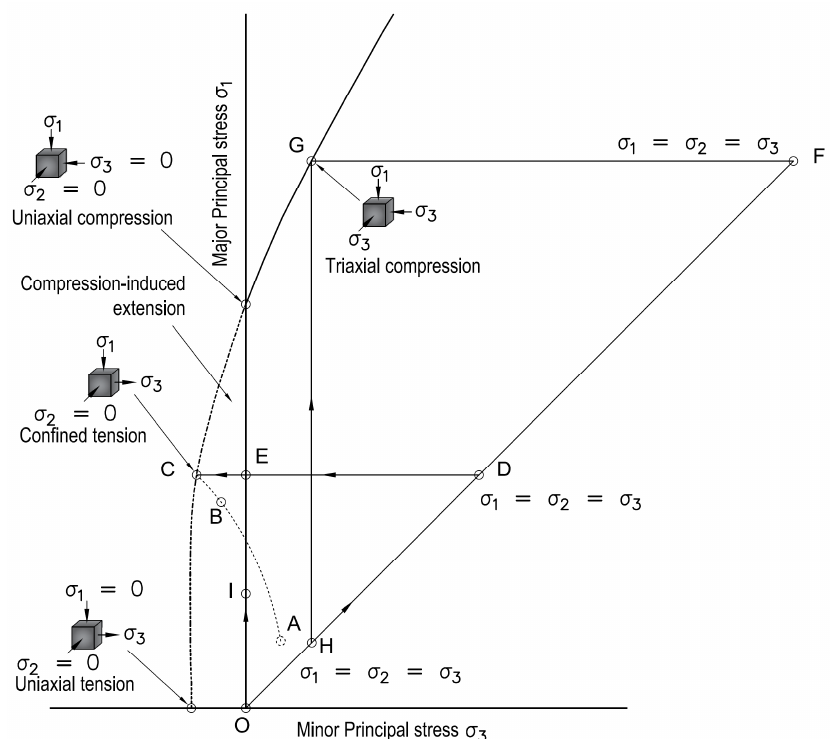
Figure 8. A typical failure envelope for rock showing the stress path during probable field-confined extension (ABC, unloading), confined extension (ODEC and OFG), and triaxial (OHG) tests. Note: the location of point A depends upon the boundary condition to which the rock is subjected in the field.